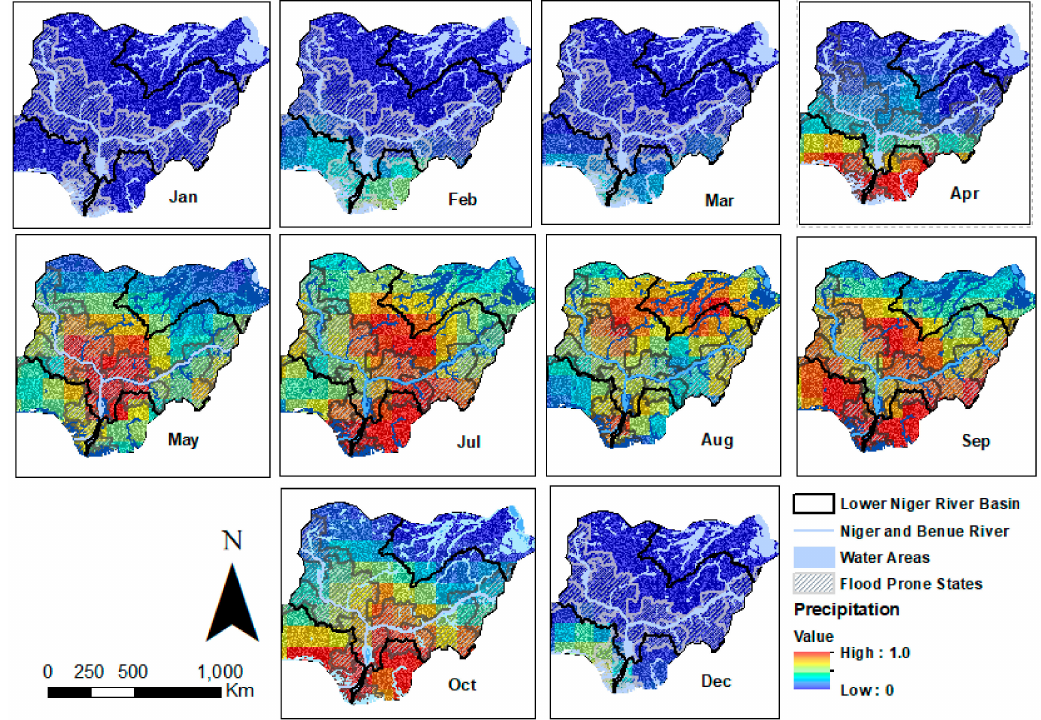
Figure 9. Spatiotemporal distribution of precipitation in the Lower Niger River Basin (LNRB) in 2012 from January to December. June and November were not displayed so as to show consistency when compared to GRACE